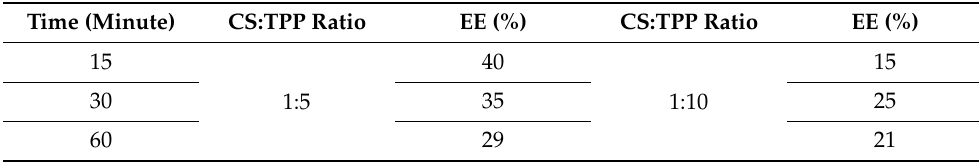
Table 1. The EE was tested for the formulations CS:TPP (1/5 and 1/10). Table 1. Encapsulation efficiency of 5ASA in CS-TPP Table 1. Encapsulation efficiency of 5ASA in CS-TPP beads.